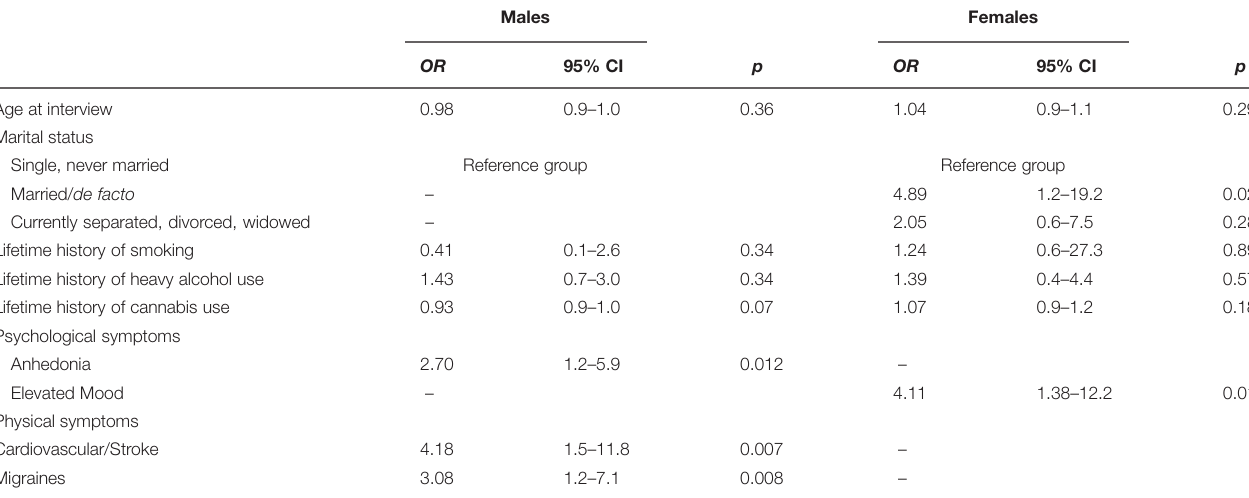
TABLE 4 | Relationship between CTA and demographics, psychological and physical health profiles in people with psychosis, stratified by